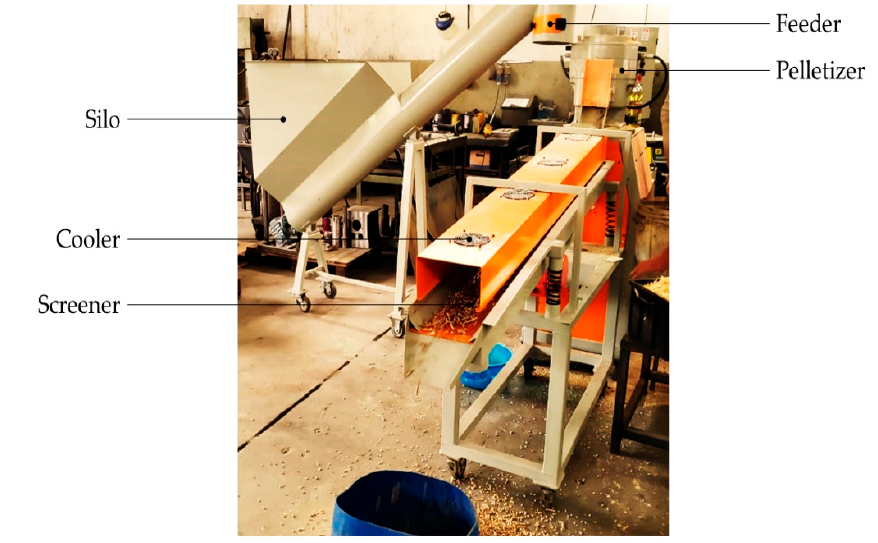
Figure 1. Pilot-scale set of pelleting.